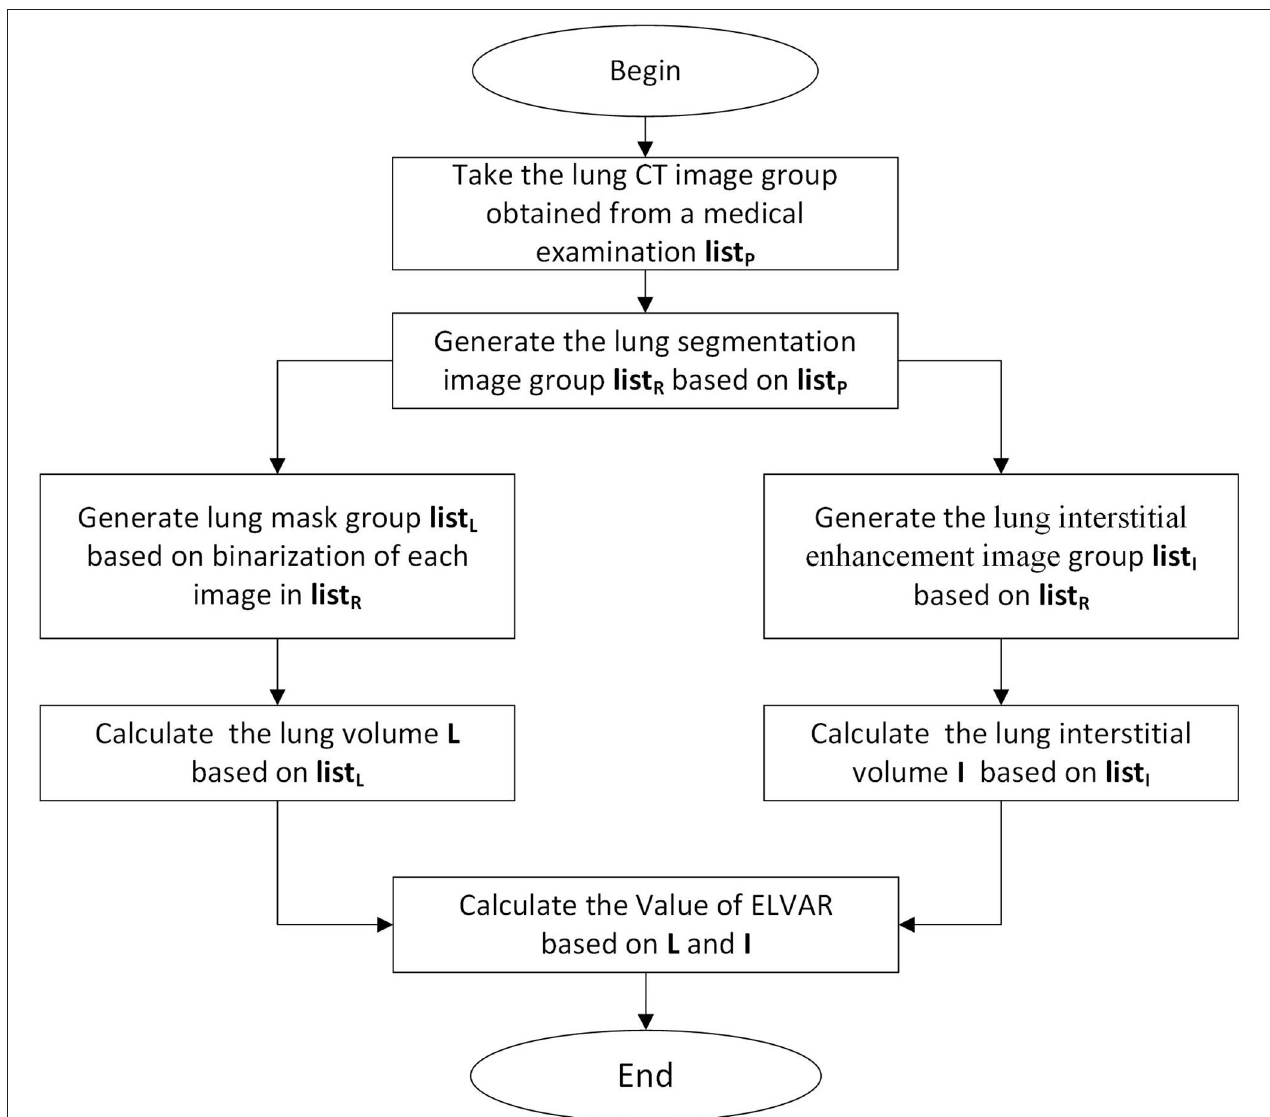
FIGURE 3 | Calculation procedure of Effective Lung Ventilation Area Ratio (ELVAR). List P were original images of lung windows from HRCT (Figure 2A) . List R were segmentation results from List P (Figure 2J) . List L were data of calculation results of List R in the algorithm program (Figure 2I) . List I were data of lung interstitial enhancement of List R in the algorithm program (Figure 2K)